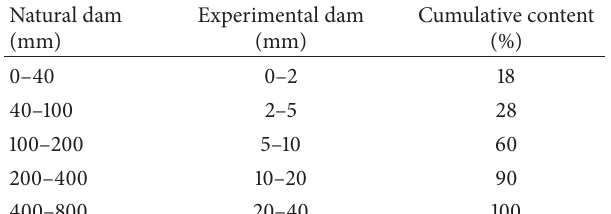
Table1:Particlesizedistributionofthenaturaldamandexperimen- tal dam.